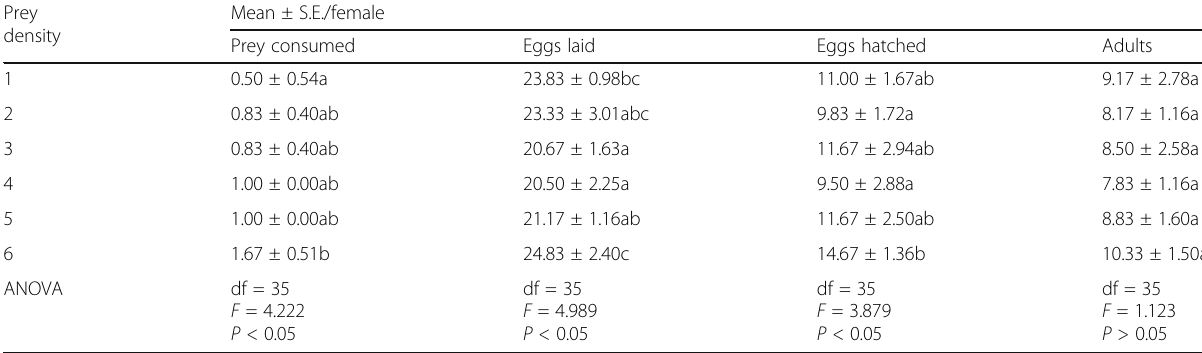
Table 6 Numerical response of predator A. biannulipes feeding on P. truncatus pupae at various densities Prey